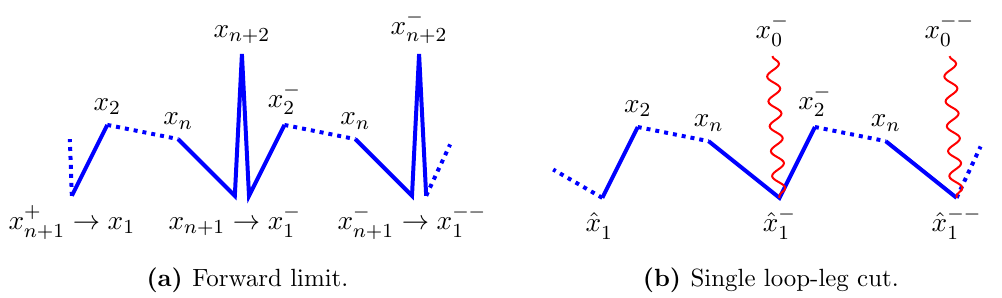
Figure 6. Illustration of the forward limits and single cuts on the periodic kinematic con(cid:12)guration. The red wiggly represents the distance ^ x 01 that becomes null at the location of the residue. This also explains the arguments of the ( n + 2)-point form factor appearing in the second line of